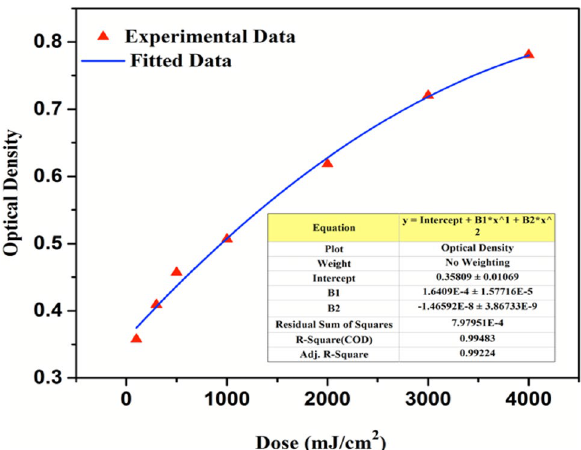
Figure 8. Calibration curve for DA 8 film